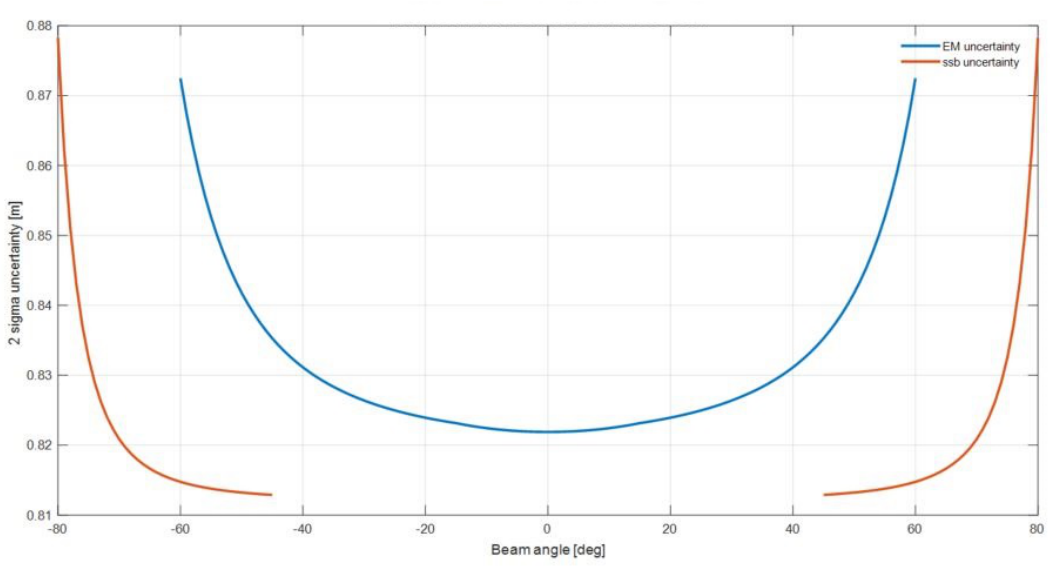
Figure 16. Total measurement uncertainties for both sonars (red, HISAS; blue, EM 2040 MBES). The AUV altitude equals 70 m.